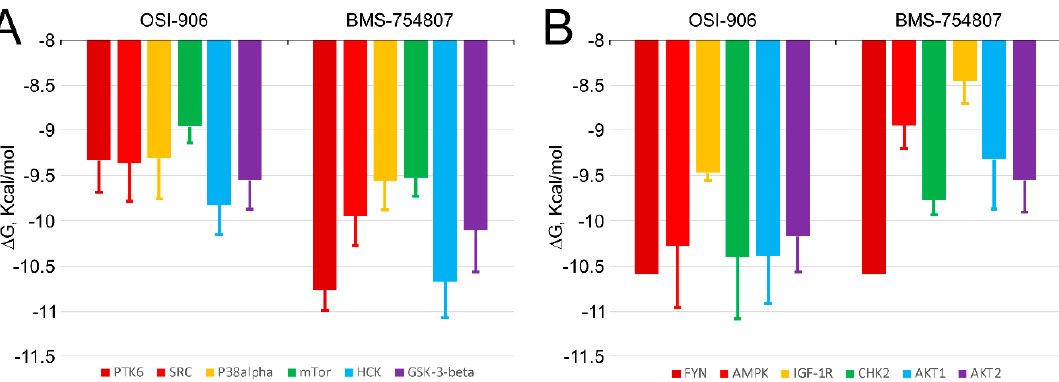
Figure 7. Comparison of Gibbs free energy variation ( Δ G, kcal/mol) for BMS-754807 and OSI-906 inhibitors based on molecular docking against the ATP-binding site of several protein kinases (see